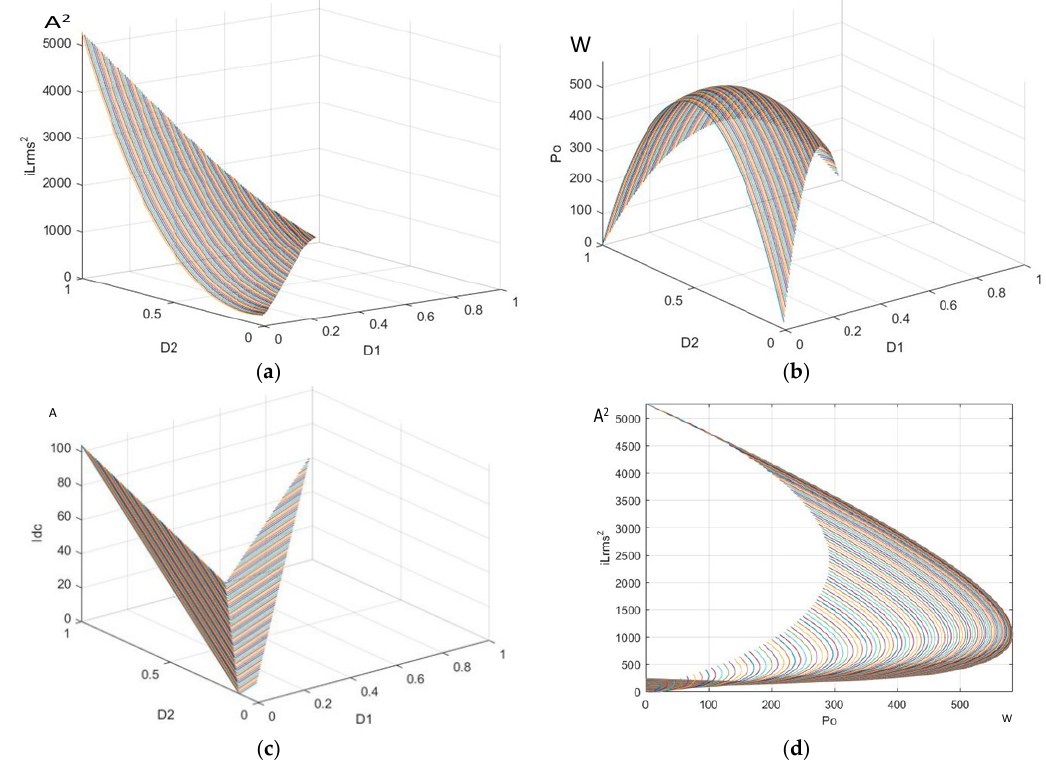
Figure 4. Function 3-D diagrams according to Table 1. ( a ) Function diagram of D 1 − D 2 − i 2 ( b ) Function diagram of D 1 − D 2 − P 0 ; ( c ) Function diagram of D 1 − D 2 − I dc ; ( d ) Function diagram of P 0 − i 2 L ( rms )